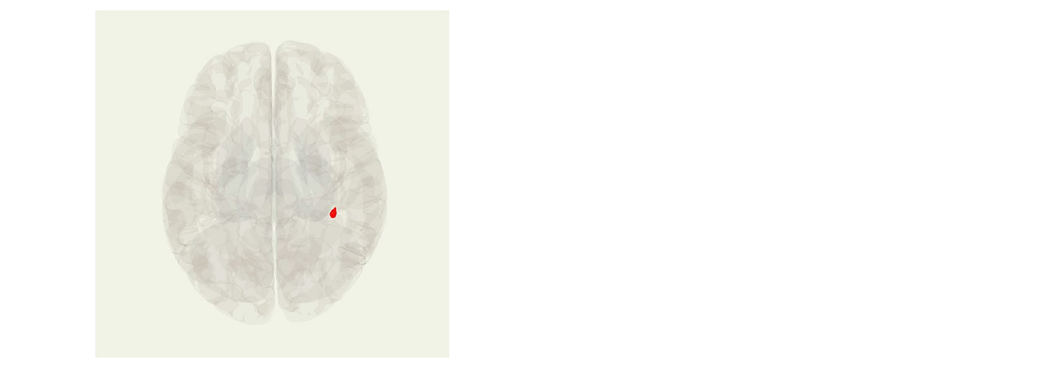
Figure 3. Significant cluster locations, red indicates increased resting state functional connectivity. Increased resting state functional connectivity from the right anterior insula to the right postcentral